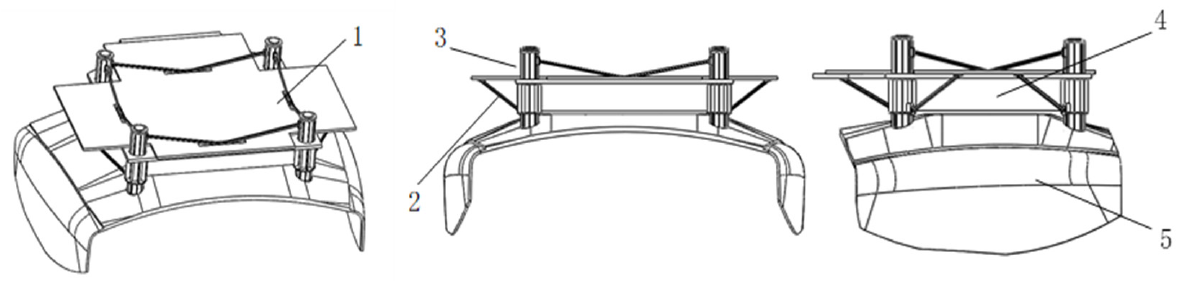
Figure 1. Flat satellite: 1—solar panel; 2—reinforced support; 3—load-bearing column; 4—Main structure and devices; 5—antenna.